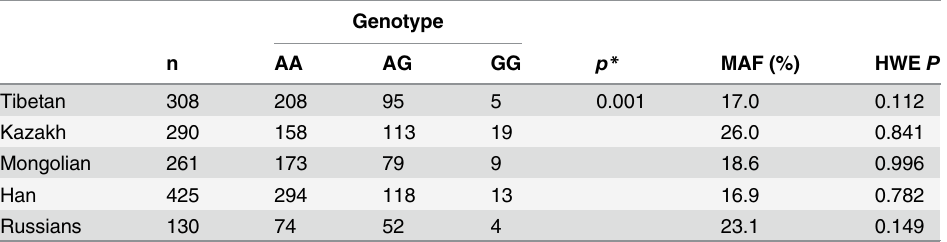
Table 3. Genotype and allele frequencies of GSTP1 Rs1695 by ethnicity.